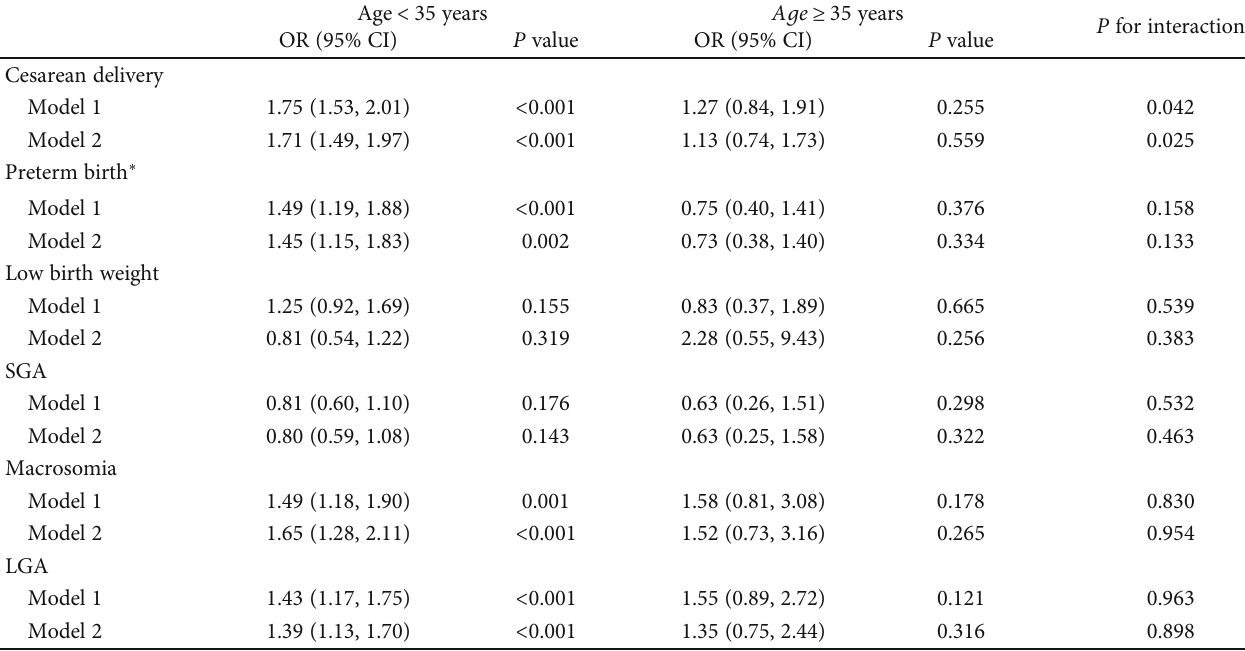
Table 3: ORs (95% CIs) for pregnancy outcomes by gestational diabetes mellitus, strati fi ed by maternal age.